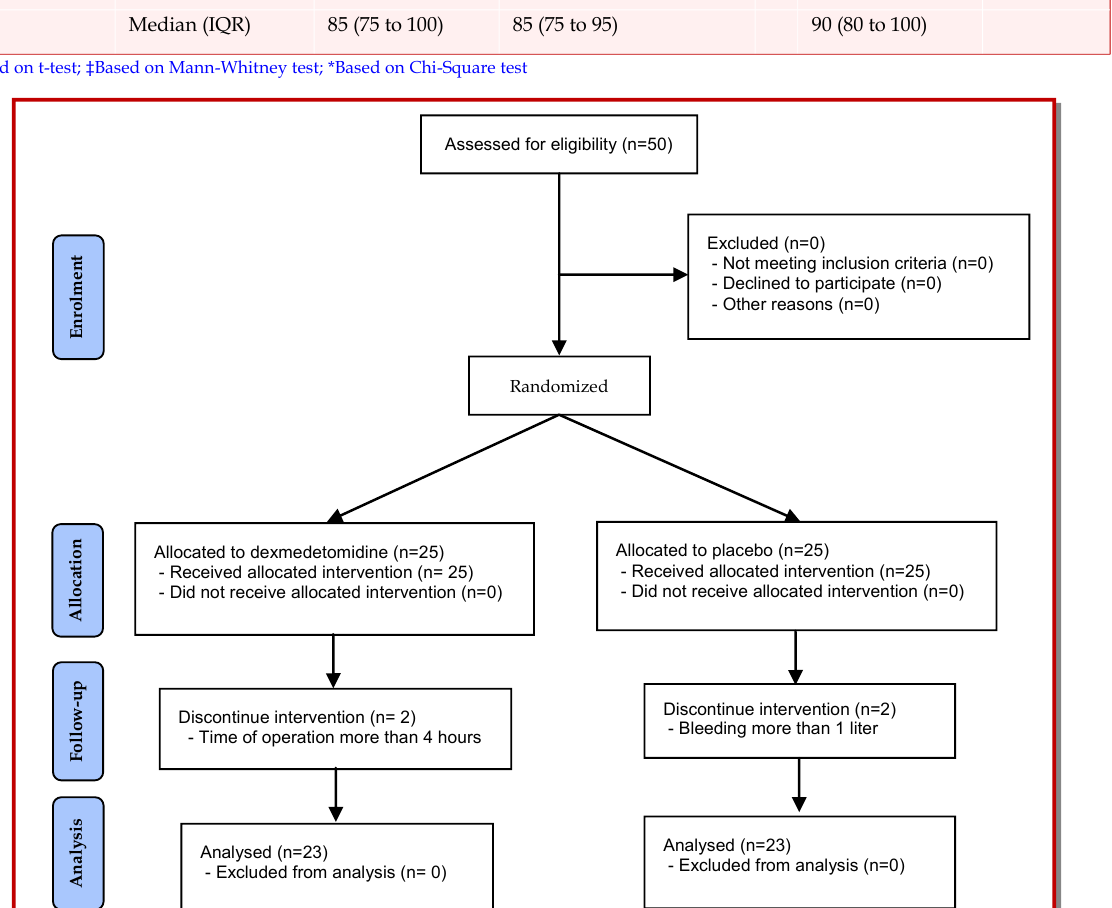
Figure 1: Consort diagram showing the flow of